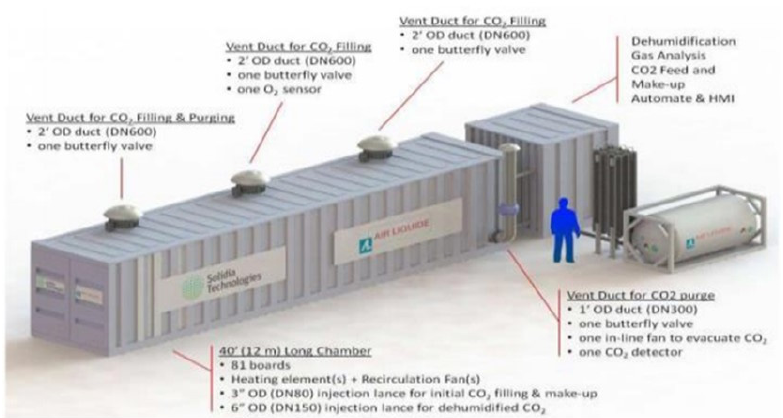
Figure 5. Solidia Carbonation Chamber. Source: